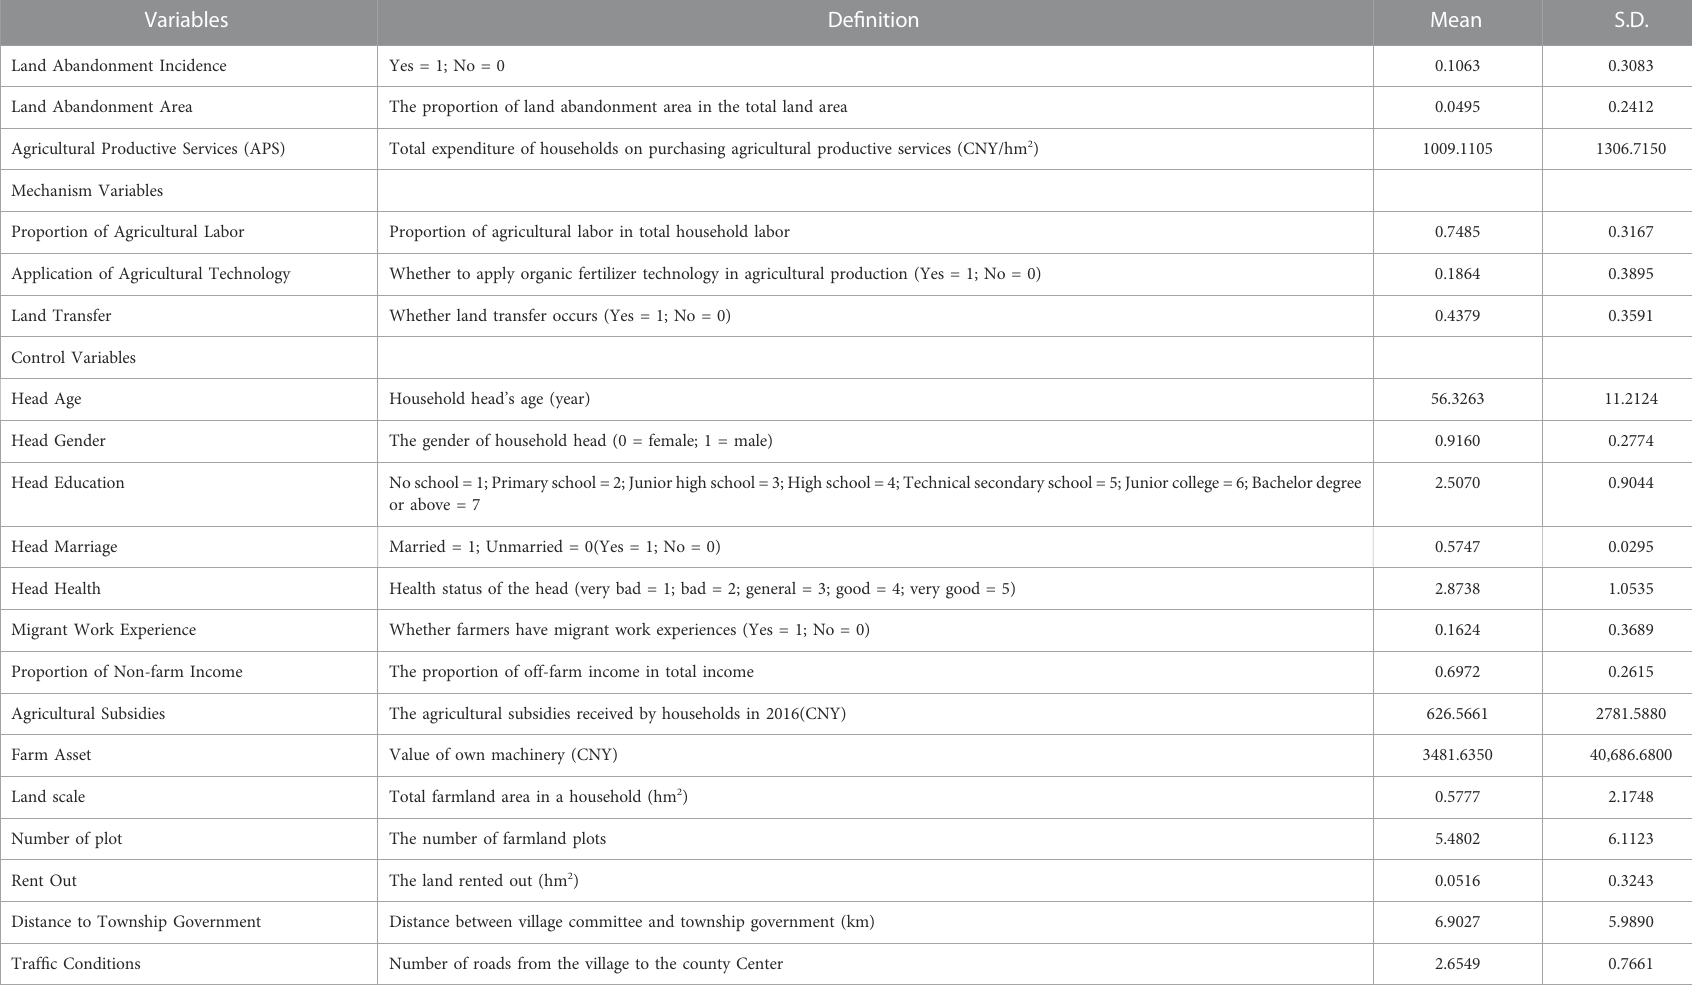
TABLE 1 De fi nition and statistical